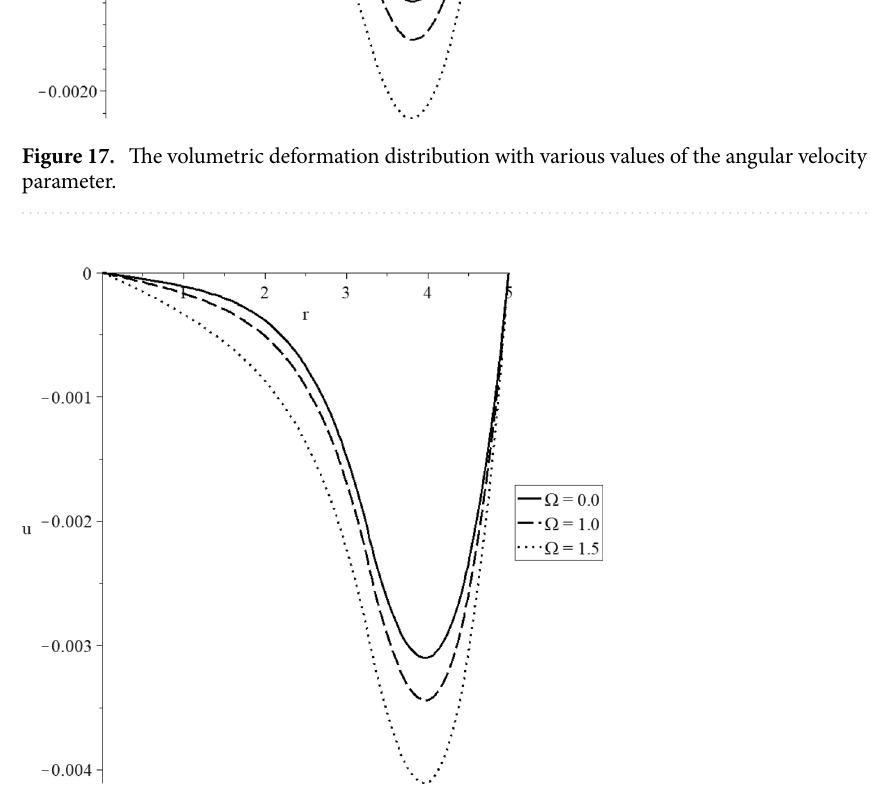
Figure 20 represents that the angular velocity parameter has significant effects on stress–strain energy distri- butions. The three curves start from the position r = 5.0 with zero values, and each curve has a peak point. The